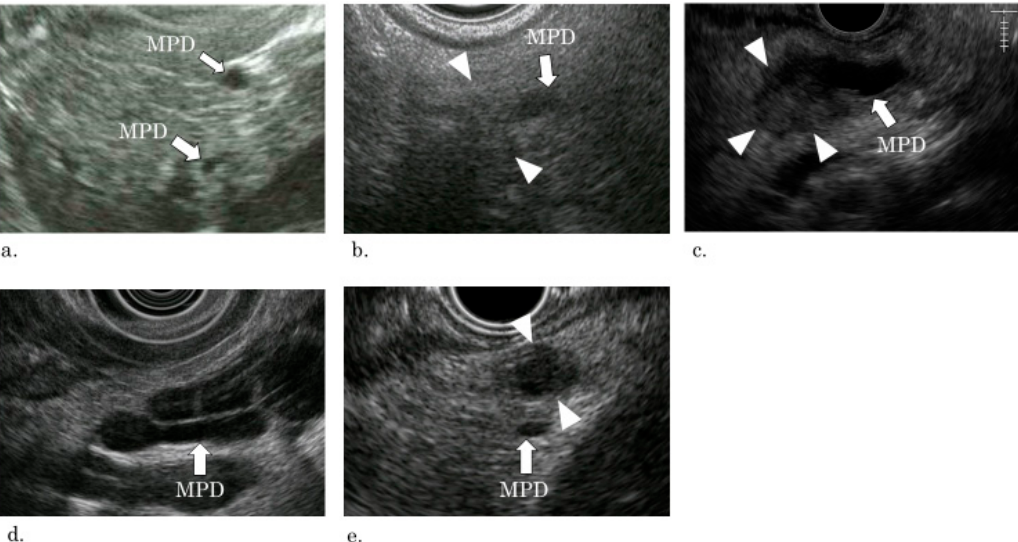
Figure 2. EUS pictures of each type of classification. ( a ) A1: Simple stricture type—the main pancreatic duct is strictured with a slight dilation of the upstream pancreatic duct, but no other finding (such as hypoecho or a tumor) is recognized at the strictured part (arrow, main pancreatic duct). ( b ) A2: Hypoecho stricture type—the main pancreatic duct is strictured by a blurred hypoechoic lesion with slight dilation of the upstream pancreatic duct (arrow, main pancreatic duct; arrow head, hypoechoic lesion). ( c ) A3: Tumor stricture type—A tumor strictures the main pancreatic duct with upstream dilation (arrow, main pancreatic duct; arrow head, tumor). ( d ) B: Dilation type—the main pancreatic duct and the branch duct is dilated without a tumor or a downstream stricture (arrow: main pancreatic duct). The cystic dilated duct is a branch duct. ( e ) C: Parenchymal tumor type—A tumor exists distant from the main pancreatic duct. (arrow, main pancreatic duct; arrow head, tumor). In this classification, a “stricture” was defined as an apparent change of the diameter of the MPD.